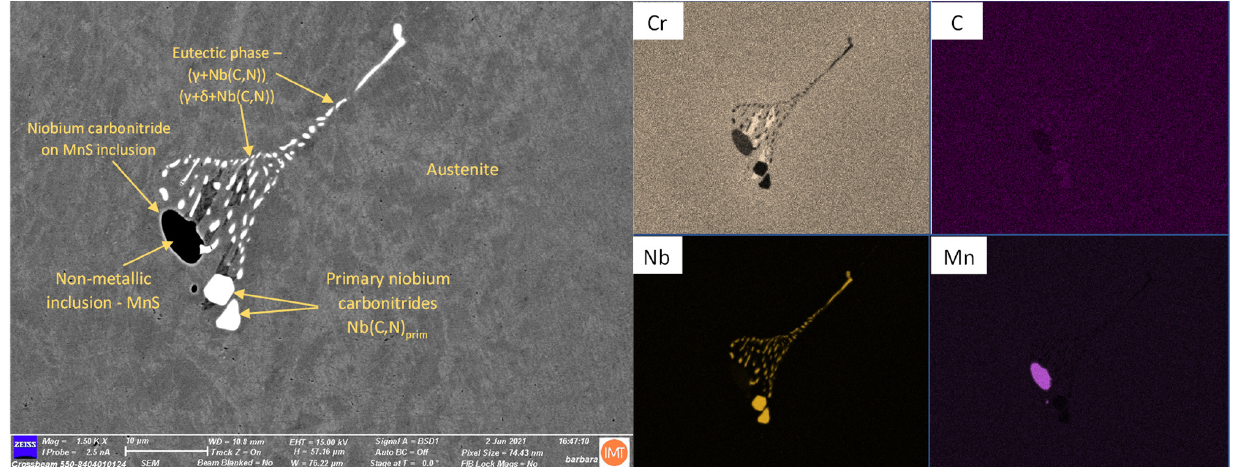
Figure 9. Backscattered electron image of MnS inclusion, niobium carbonitrides, and eutectic phase agglomerate in the austenite matrix in the 10Ni-70 steel sample, and EDS of Cr, C, Nb, and Mn.